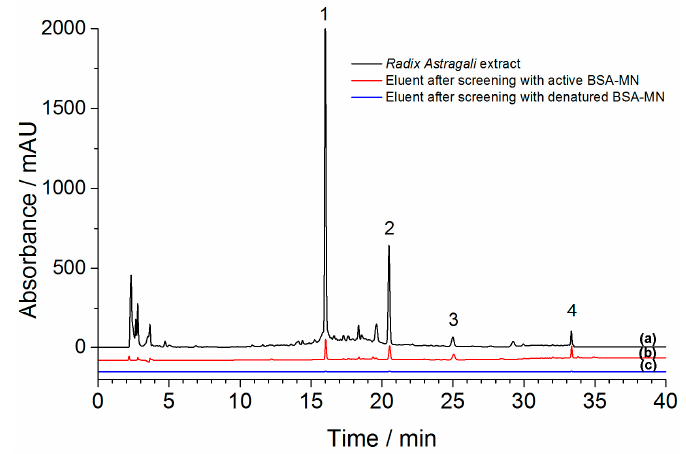
Figure 8. The chromatograms of ( a ) n -butanol part of Radix astragali extract ( black ); ( b ) eluent after screening with active BSA-MN ( red ) and ( c ) eluent after screening with denatured BSA-MN ( blue ).